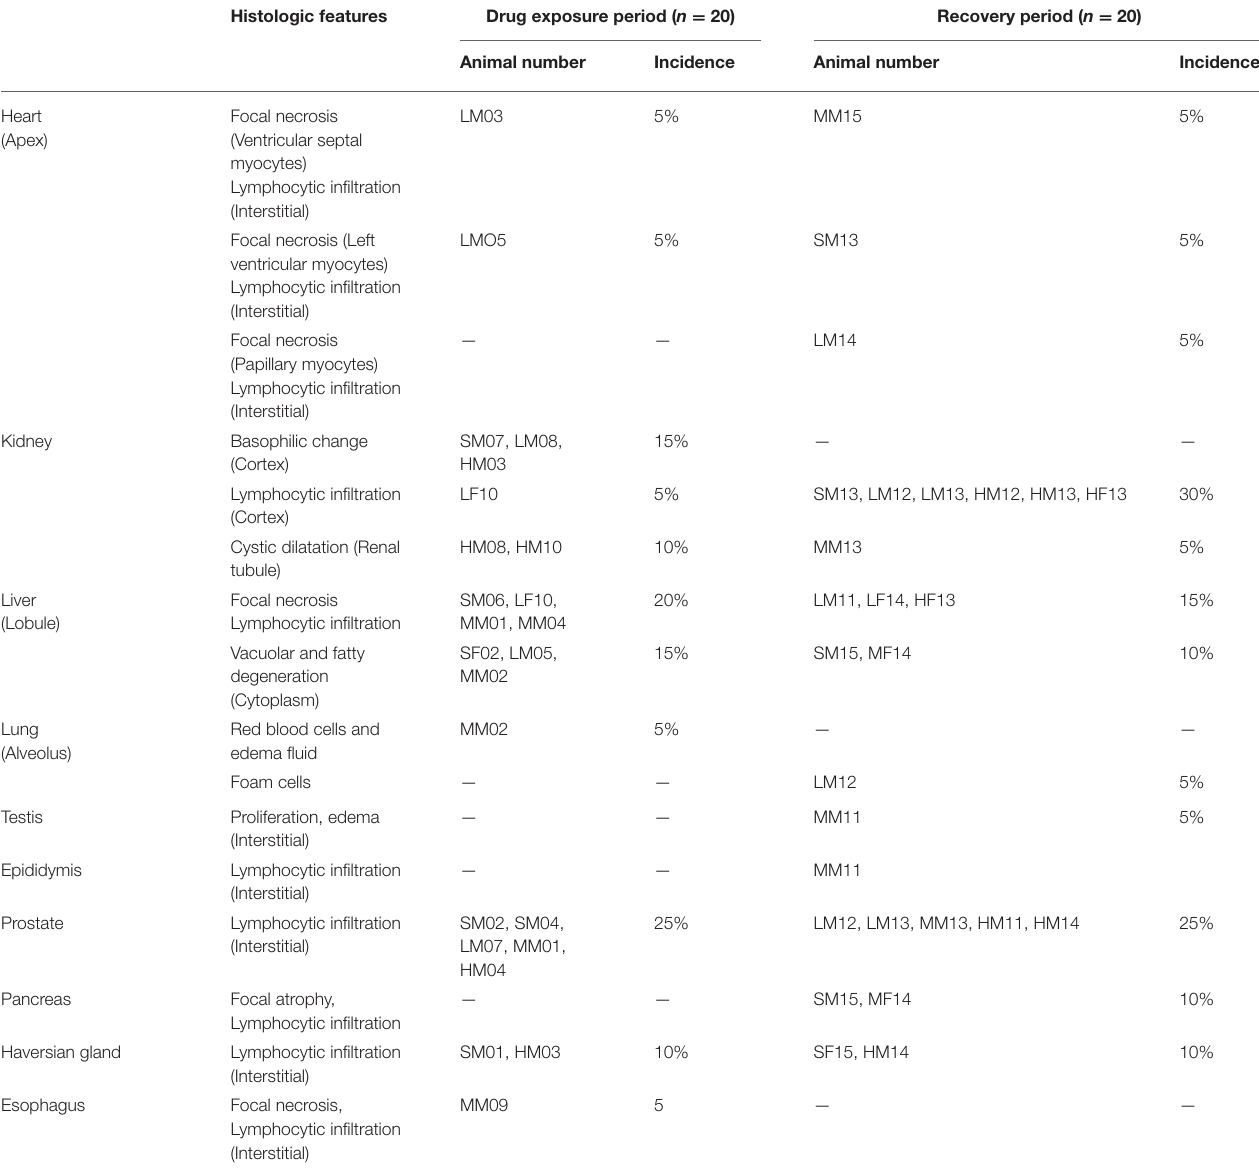
TABLE 8 | The histologic features of Arctigenin (12-, 36-, and 120 mg/kg) administration by gavage (i.g) in rats after drug exposure period ( n = 20, 10 female, 10 male) and recovery period ( n = 20, 10 female, 10 male). Histologic